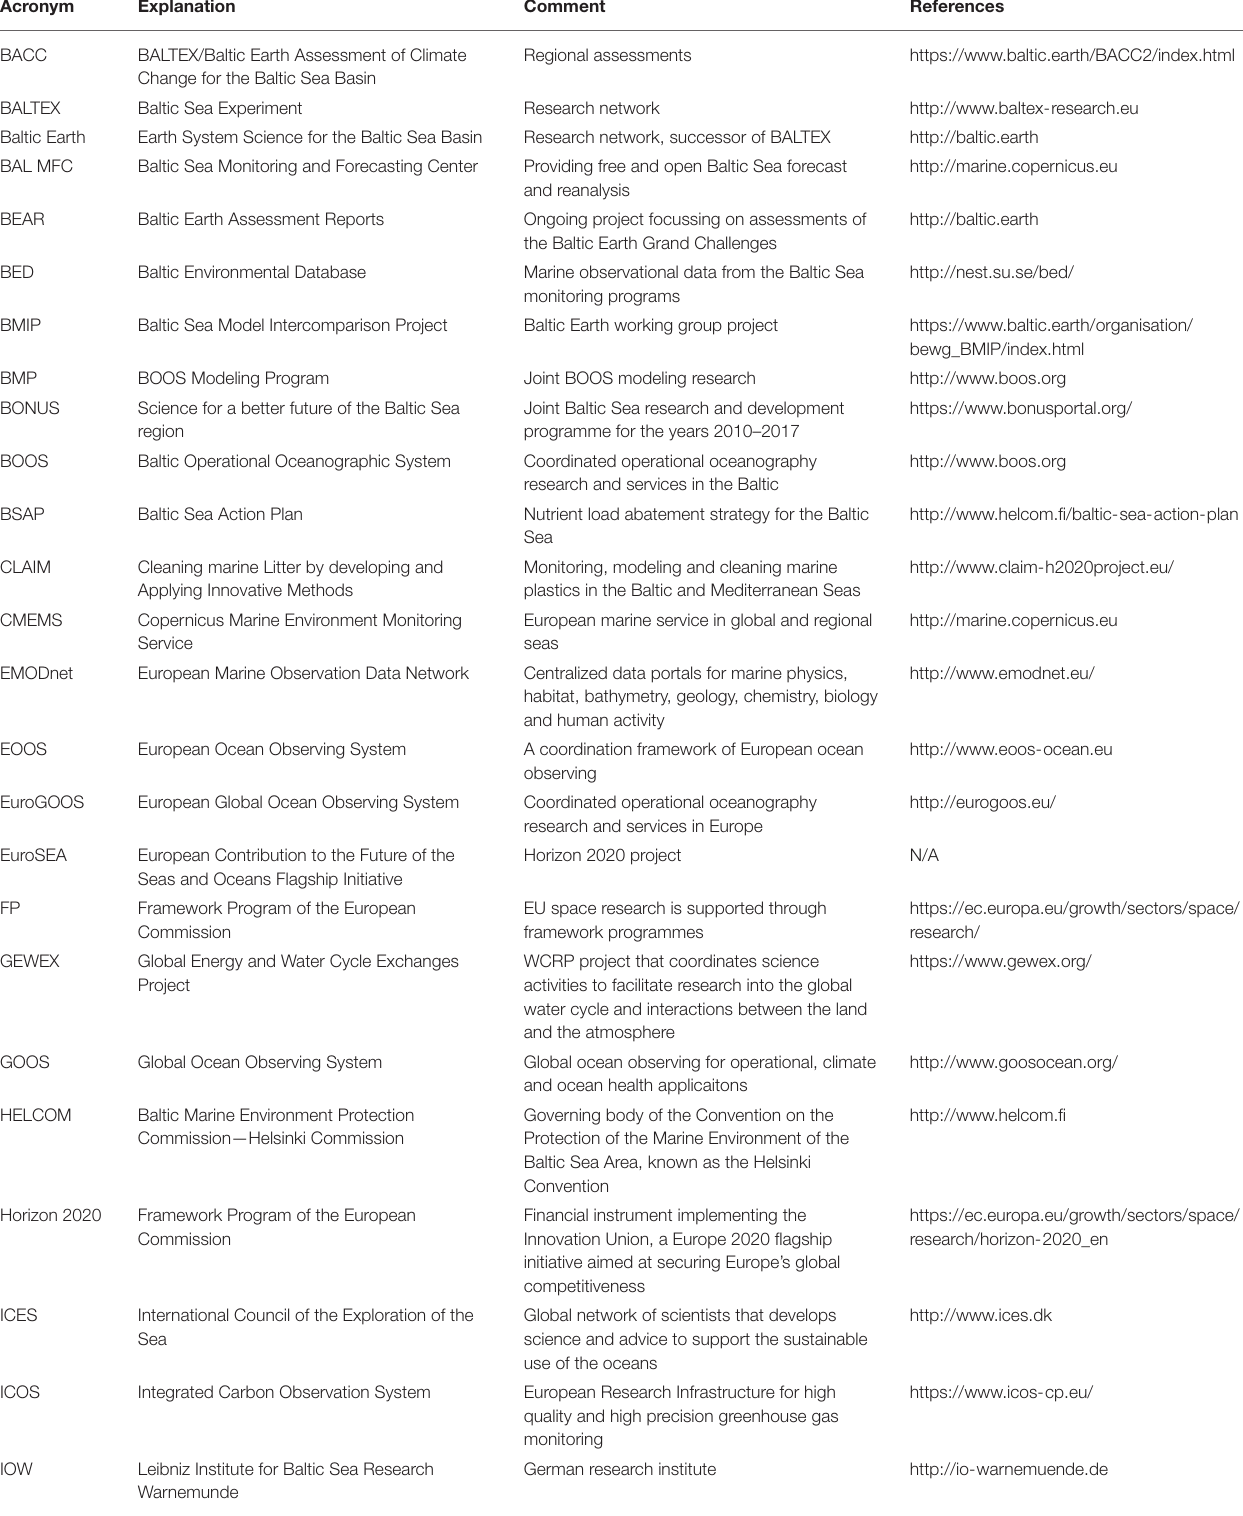
TABLE 1 | List of frequently used acronyms, their explanation, and references (in alphabetical order, assessed on